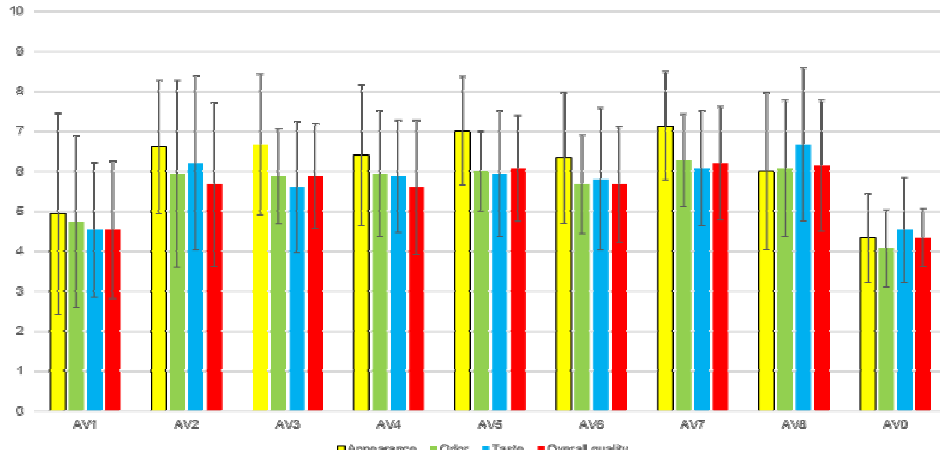
Fig. 2. Sensorial analysis of wines made with different yeast